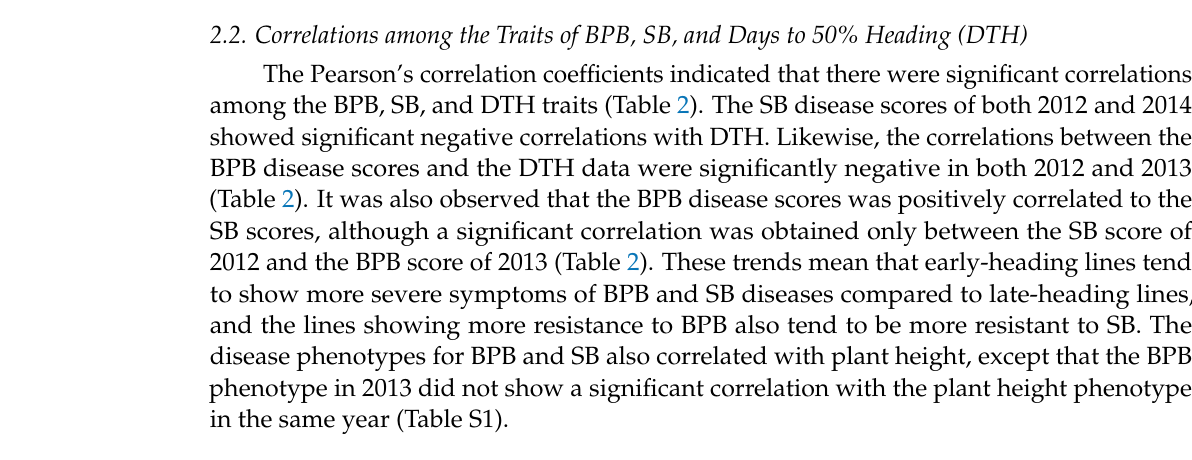
Table 2. Pearson correlation matrix of bacterial panicle blight (BPB), sheath blight (SB), and days to 50% heading (DTH) traits in